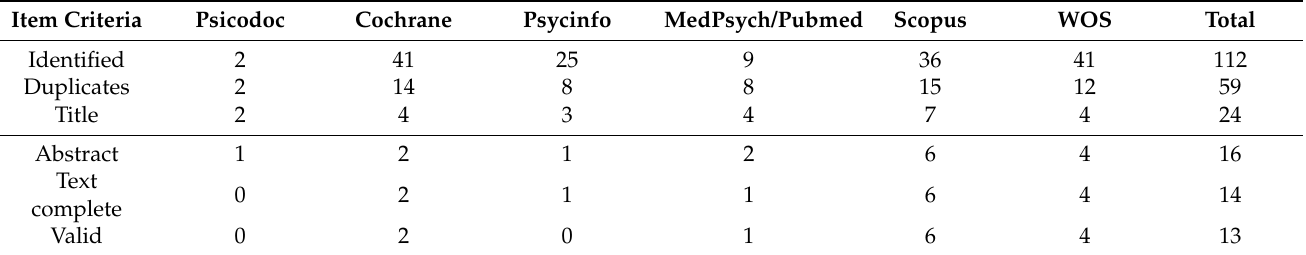
Table 2. Databases consulted.